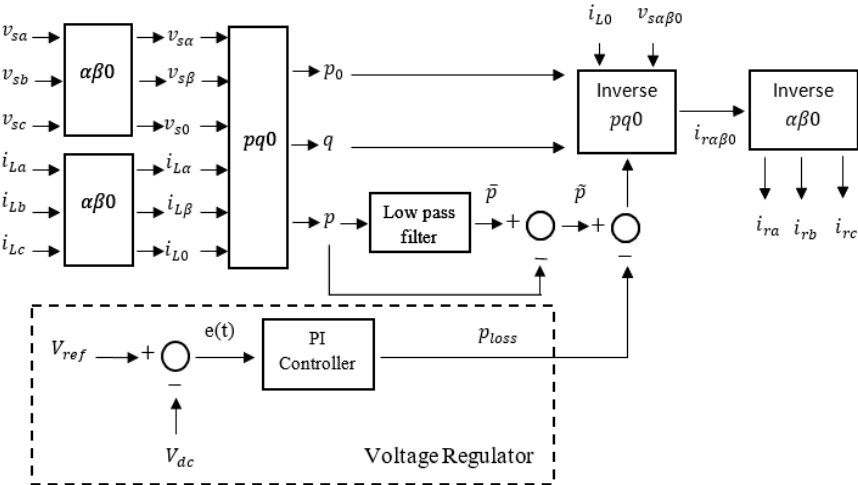
Figure 9. Pq0 theory-based comprehensive control activity.